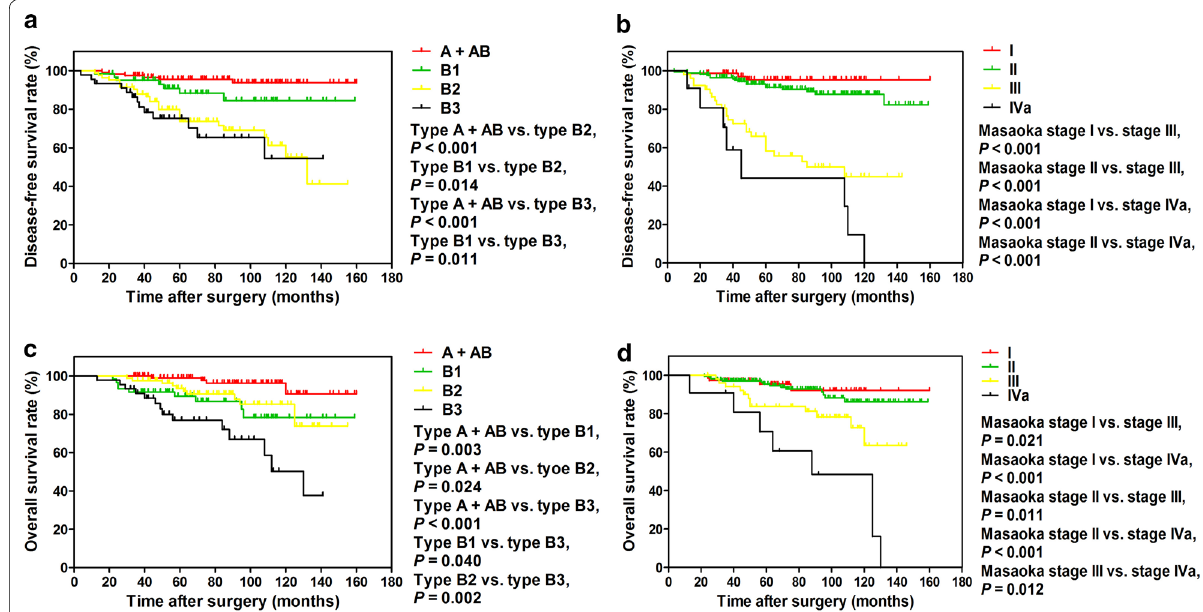
Fig. 1 Kaplan–Meier analysis of survival curves for patients with thymoma after initial resection. a Disease‑free survival curves stratified according to the WHO histological classification. b Disease‑free survival curves stratified according to the Masaoka stage. c Overall survival curves stratified according to the WHO histological classification. d Overall survival curves stratified according to the Masaoka